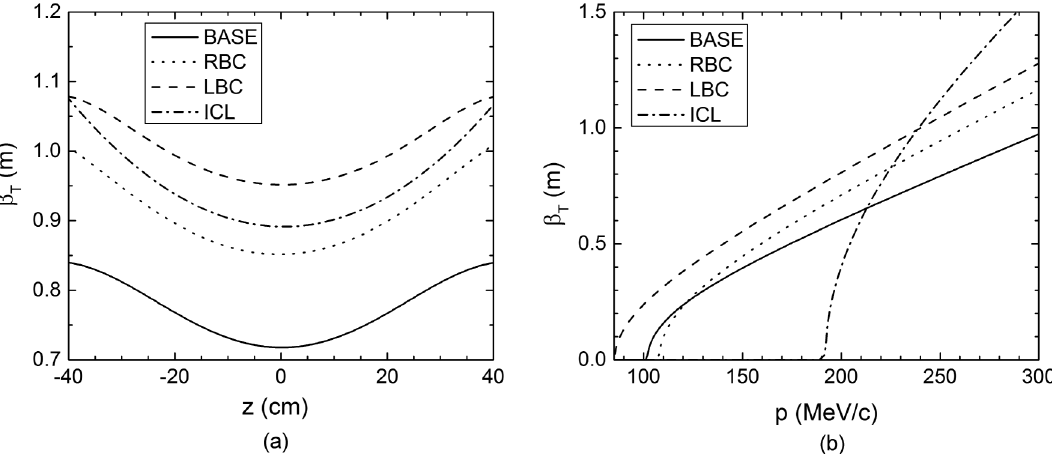
FIG. 7. Evaluation of lattice functions for the different cooling schemes: (a) Transverse betatron function along the beam axis at 230 MeV =c ; and (b) transverse betatron function with respect to the total momentum. The cell center is at z ¼ 0